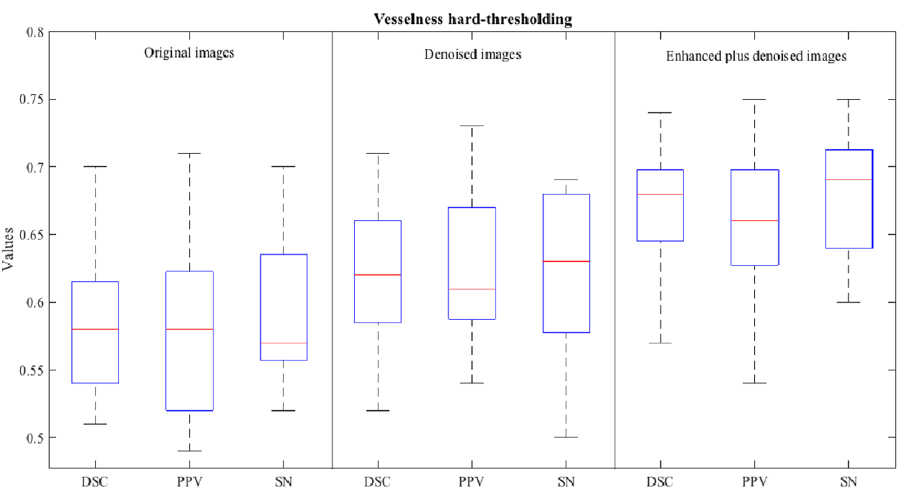
Figure 8. Segmentation accuracies of the vesselness hard-thresholding method for the original 7 T MR images (left), denoised images (middle), and our enhanced and denoised images